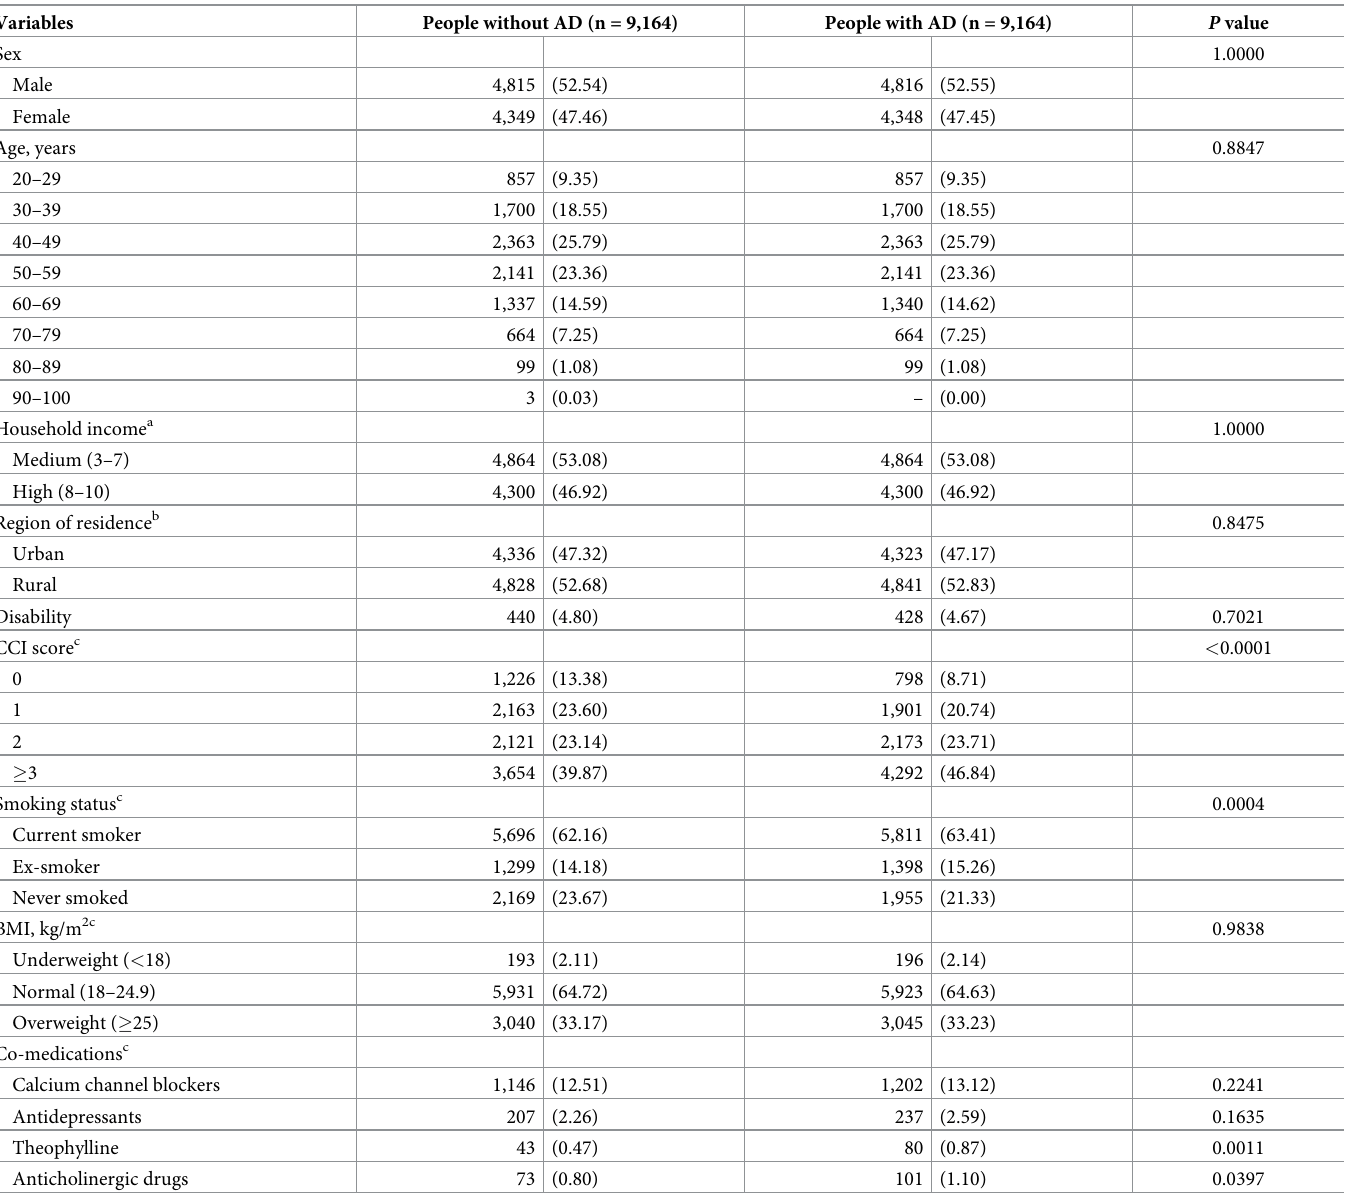
Table 1. Baseline characteristics of the study population after